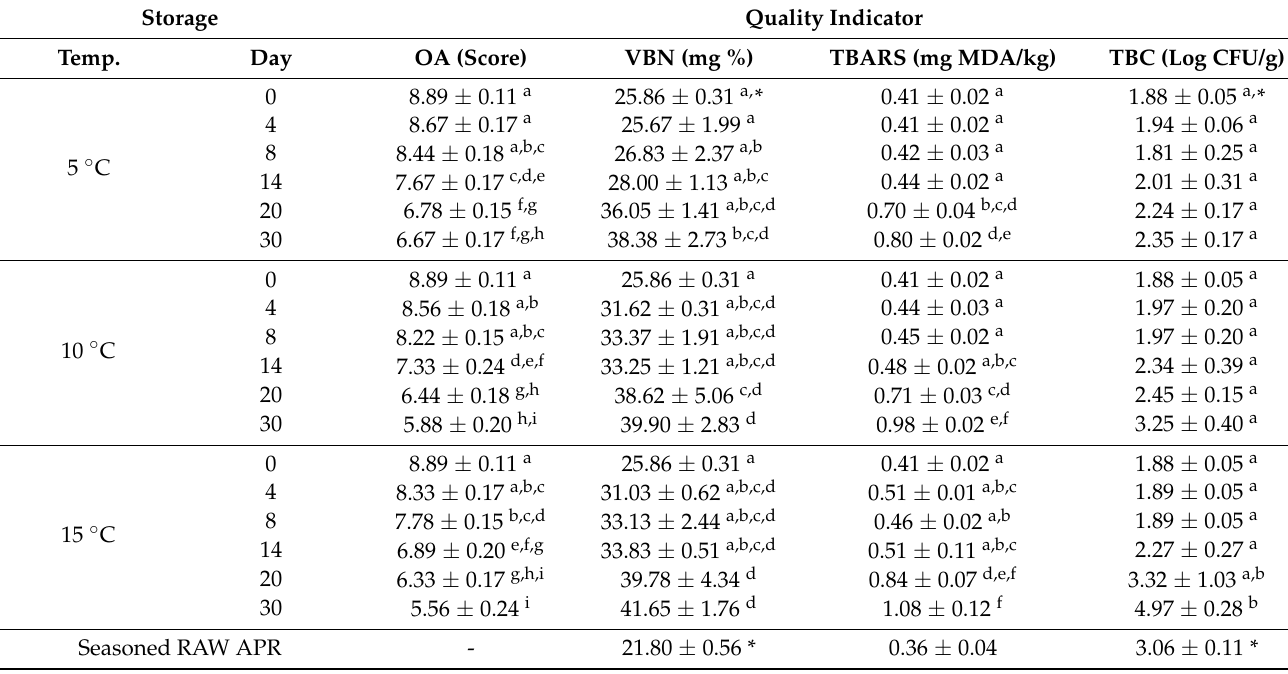
Table 8. The changes in overall acceptance (OA), volatile basic nitrogen (VBN), thiobarbituric acid reactive substances (TBARS), and total bacterial count (TBC) in seasoned raw Alaska pollack roe (APR) and smoke-roasted APR during storage at three different refrigerator temperatures. Storage Quality Indicator